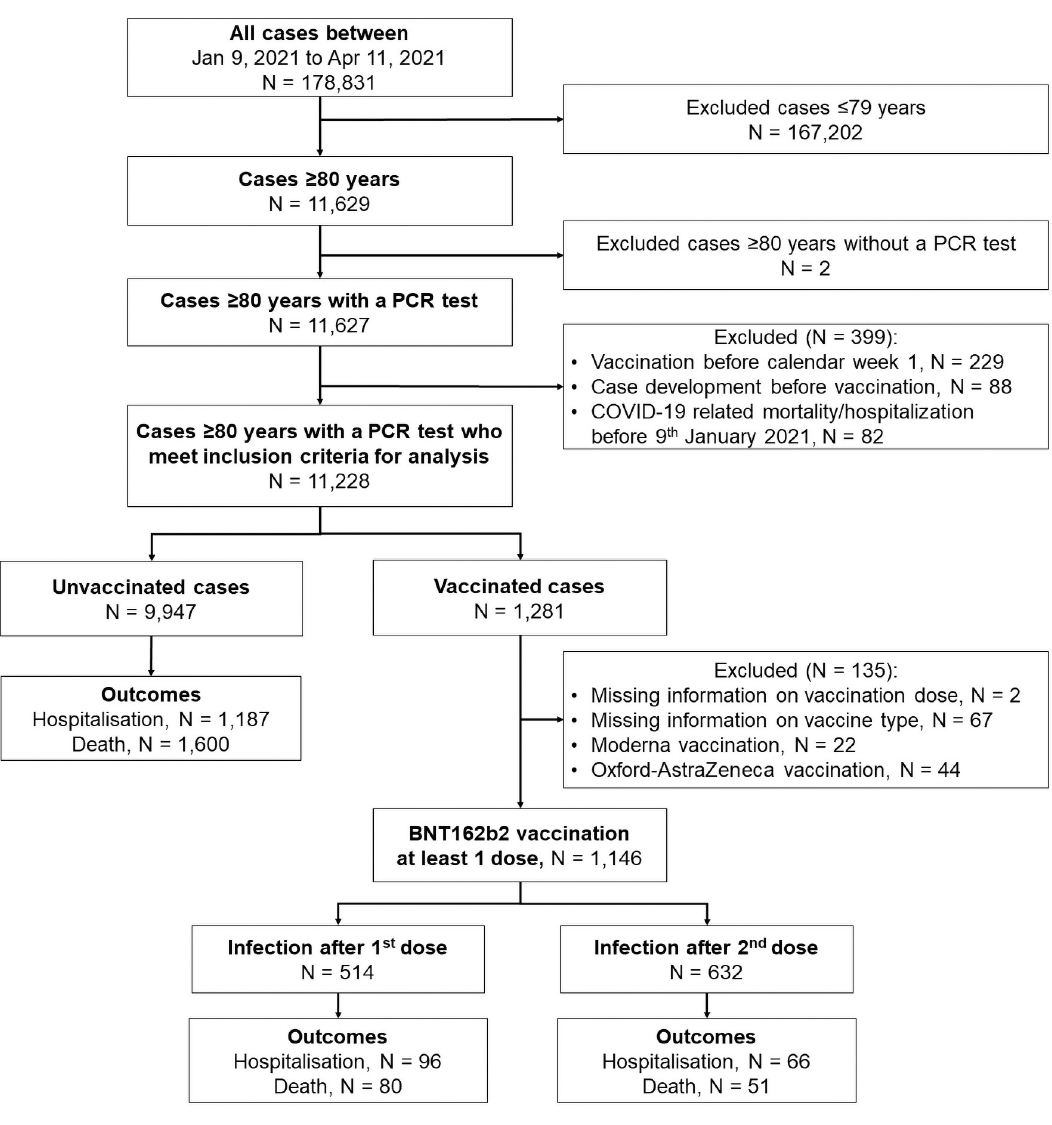
Fig 2. Flow chart of the study